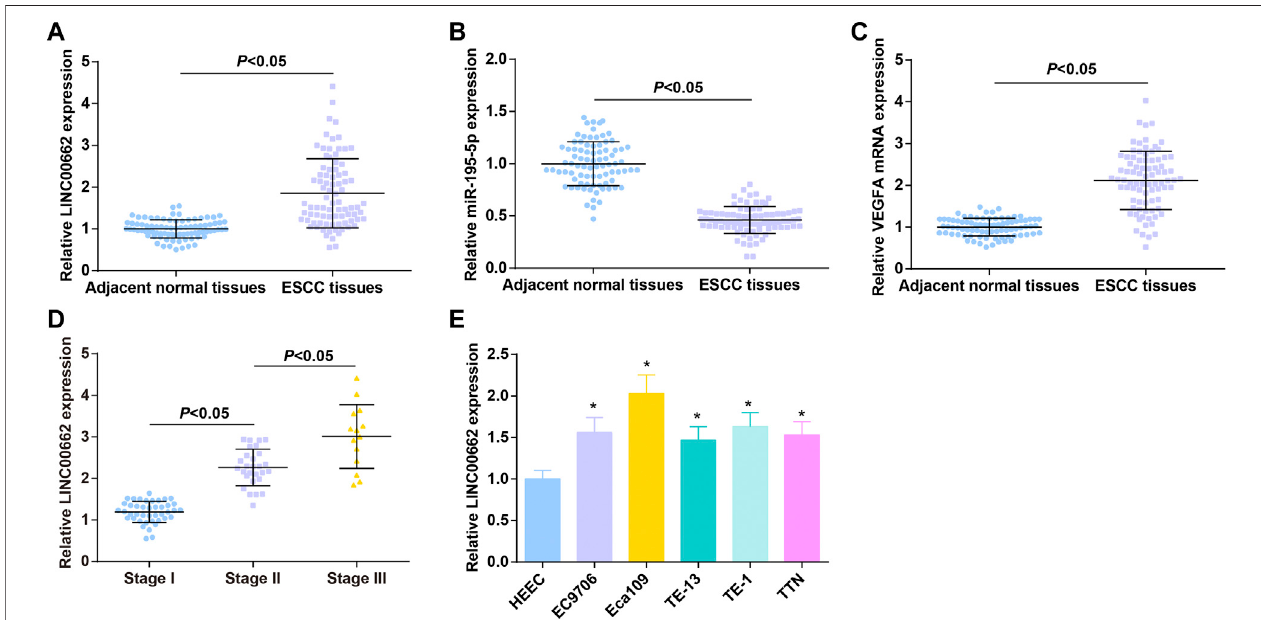
FIGURE 1 | High LINC00662 and VEGFA and low miR-195-5p in cancer tissues of patients with ESCC. (A – C) . RT-qPCR detection of LINC00662, miR-195-5p, VEGFAexpressioninESCCtissuesandadjacentnormaltissuesofpatients; (D) RT-qPCRdetectionofLINC00662expressioninESCCpatientsatdifferentTNMstages; (E) RT-qPCR detection of LINC00662 expression in HEEC and ESCC cell lines. * p < 0.05 vs. HEEC